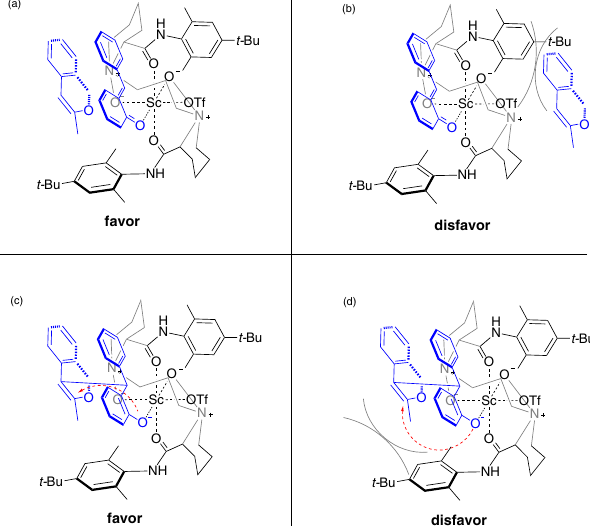
Fig. 8 Proposed stereochemical models. a Favor transition state of fi rst step. b Disfavor transition state of fi rst step. c Favor transition state of second step. d Disfavor transition state of second Experimental procedure for synthesis of 6 . Under Ar atmosphere, to a 10-mL test-tube were sequentially added 4d (0.4mmol, 136.8 mg) (89% ee ), CH 2 Cl 2 (2.0 mL), Et 3 SiH (0.4 mmol, 46.4mg) and BF 3 ·Et 2 O (0.2 mL) in 0 °C. Upon completion (2h) the residual was puri fi ed by silica gel fl ash chromatography (petroleum ether: